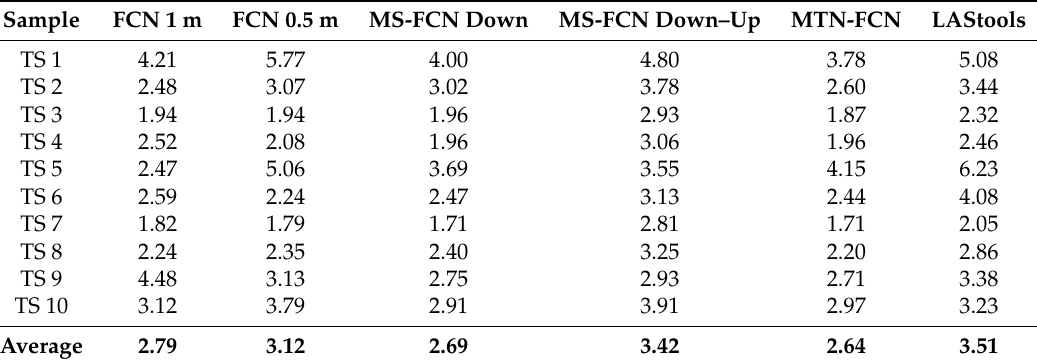
Table 5. Total errors of the AHN3 dataset.